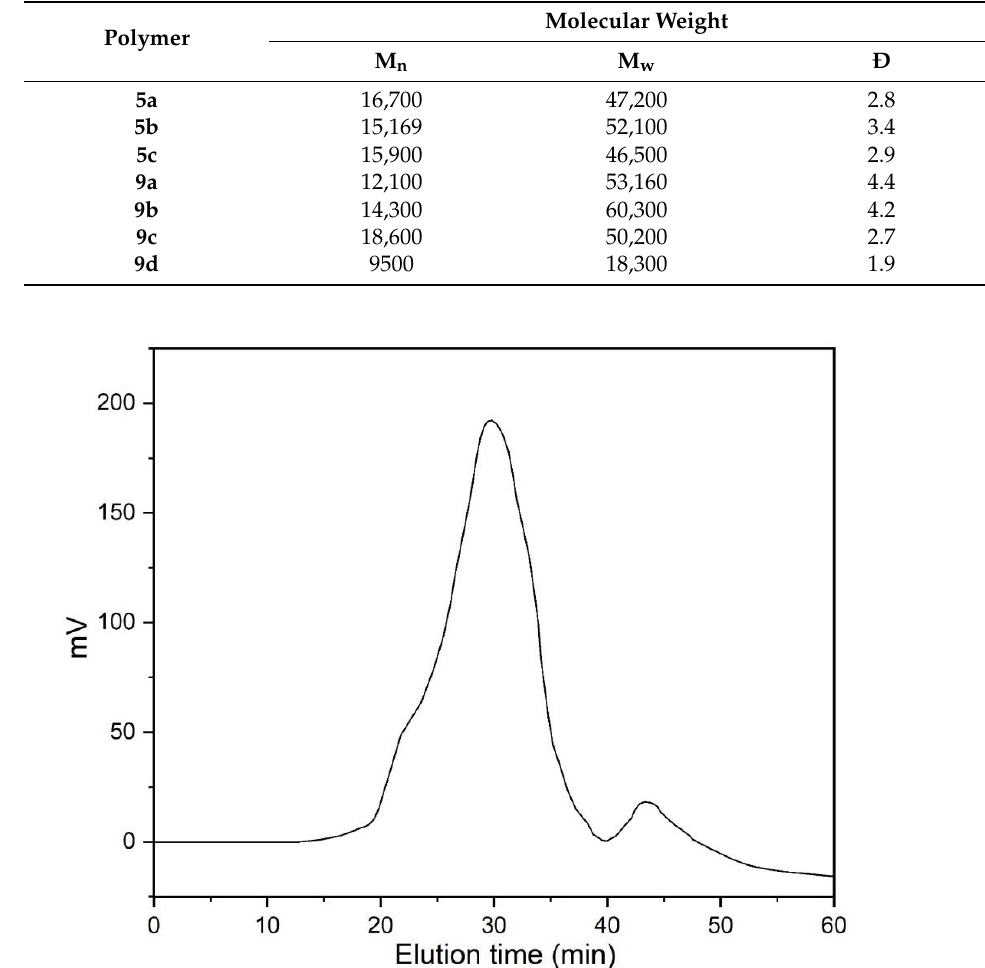
Figure 3. Molecular weight distribution chromatogram of novolac 5a from GPC.